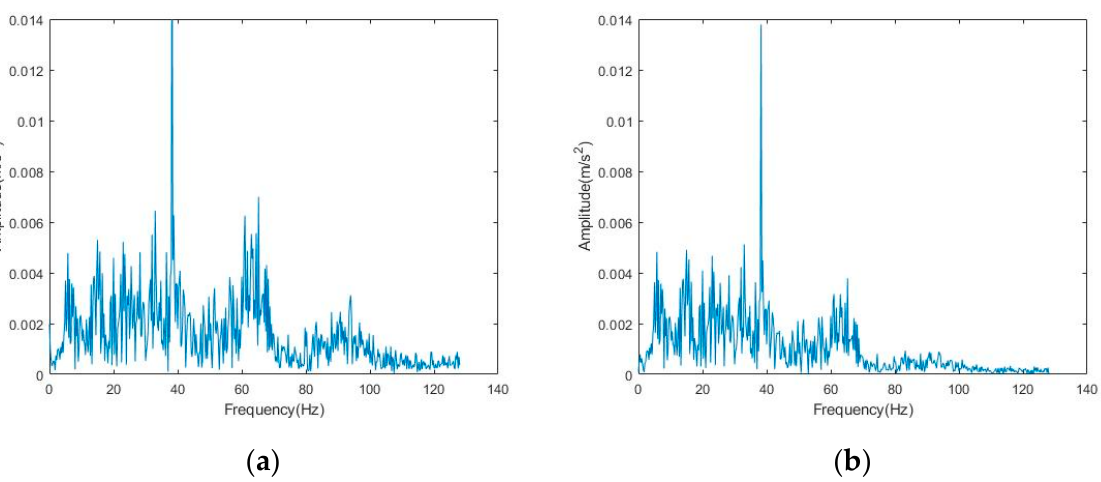
Figure 11. Frequency domain diagram of y -axis signal before and after denoising: ( a ) noisy signal; ( b ) CEEMD-BF denoising method.